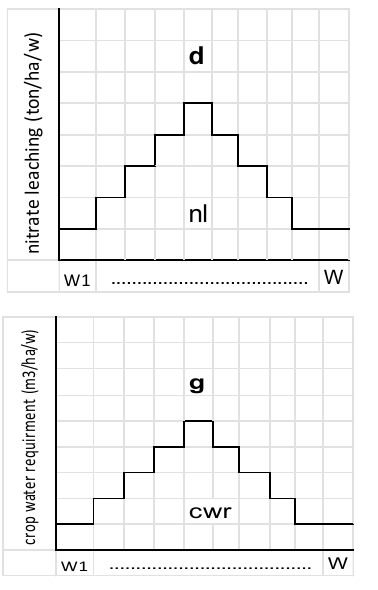
Figure 8. Input parameter characteristics used in the model for the alternative crop succession: ( a ) food calorie (cal), ( b ) crop income(ci), ( c ) crop cost (cc), ( d ) nitrate leaching (nl), ( e ) soil loss (sl), ( f ) soil carbon sequestration (soc), ( g ) crop water requirement